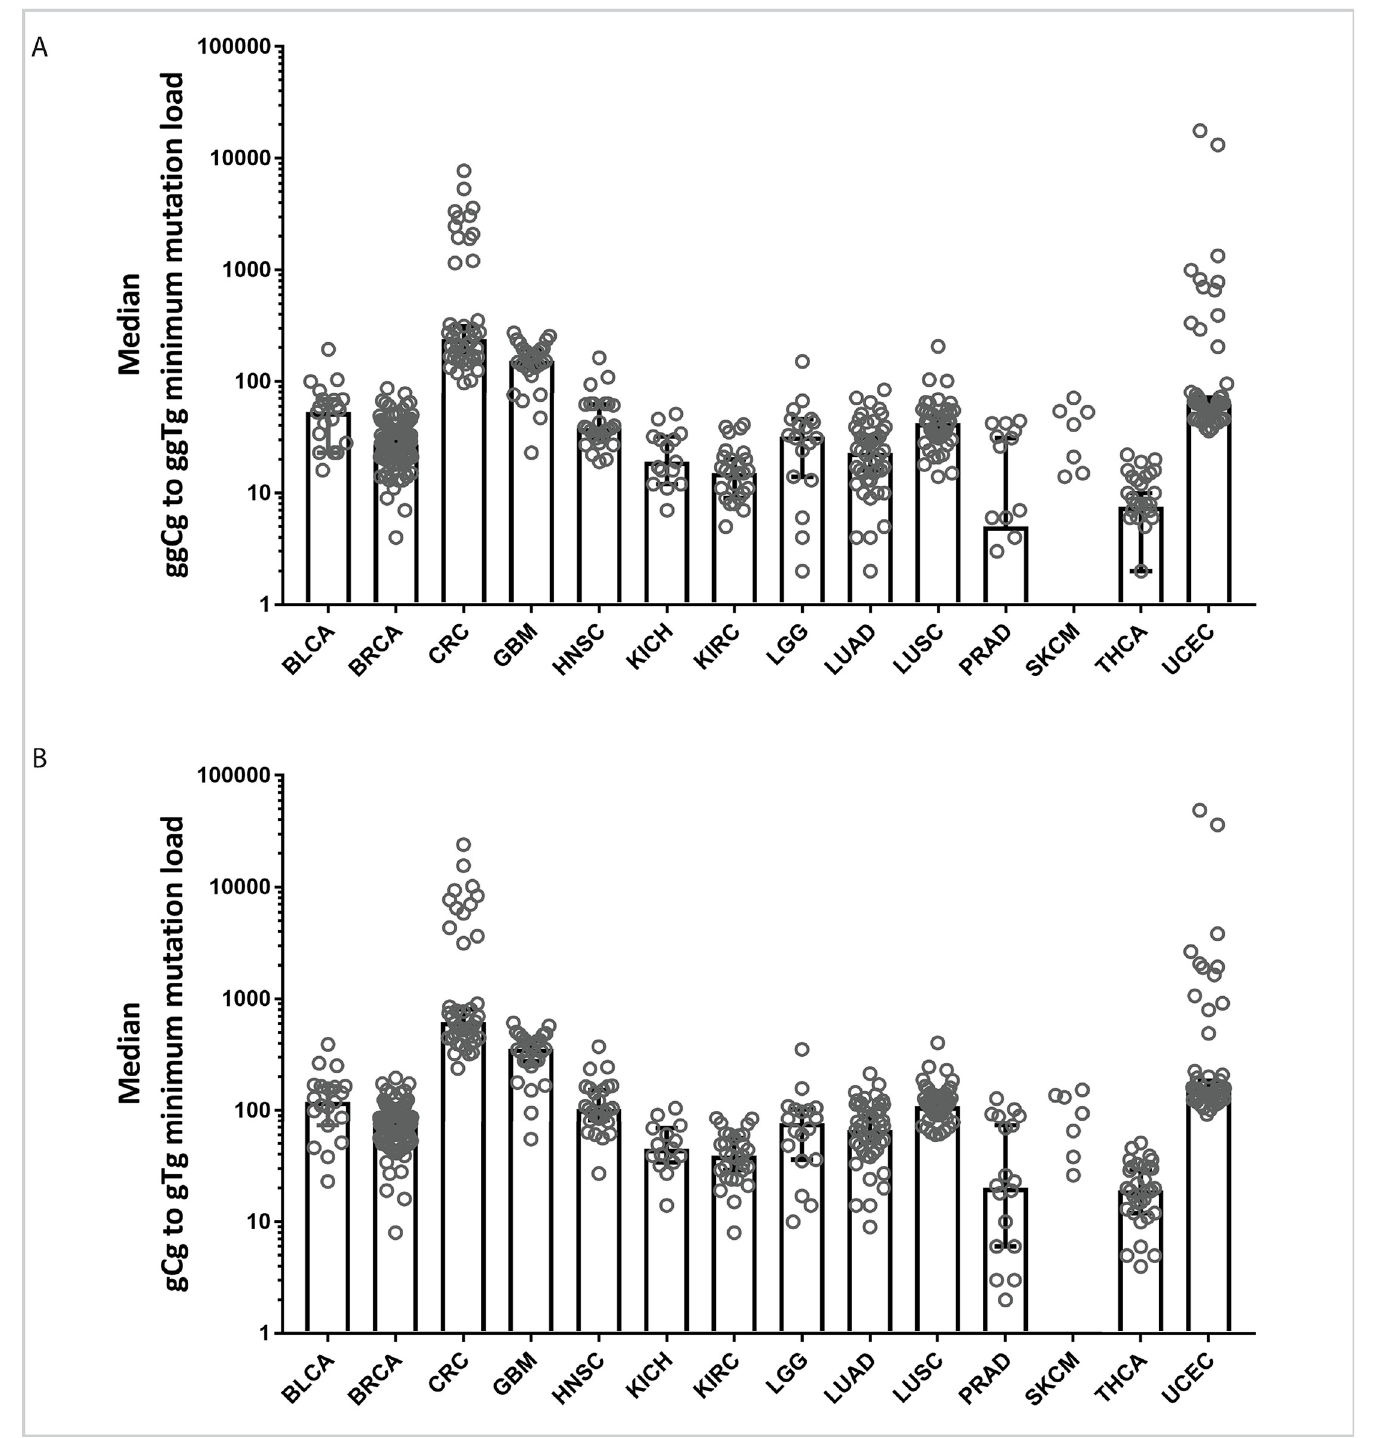
Fig 9. Evidence for redox stress–related signatures in human cancers. Medians of minimum estimates of mutation load assigned to ggCg to ggTg (A) and gCg to gTg (B) signatures are depicted as bars. Gray circles represent minimum mutation load for each individual cancer genome sample. Whiskers of the bars represent standard errors. See also S1 Data. BLCA, bladder urothelial carcinoma; BLCA, breast invasive carcinoma; CRC, colorectal carcinoma; GBM, glioblastoma multiforme; HNSC, head and neck squamous cell carcinoma; KICH, kidney chromophobe; KIRC, kidney renal clear cell carcinoma; LGG, brain lower-grade glioma; LUAD, lung adenocarcinoma; LUSC, lung squamous cell carcinoma; PRAD, prostate adenocarcinoma; SKCM, skin cutaneous melanoma; THCA, thyroid carcinoma; UCEC, uterine corpus endometrial carcinoma.